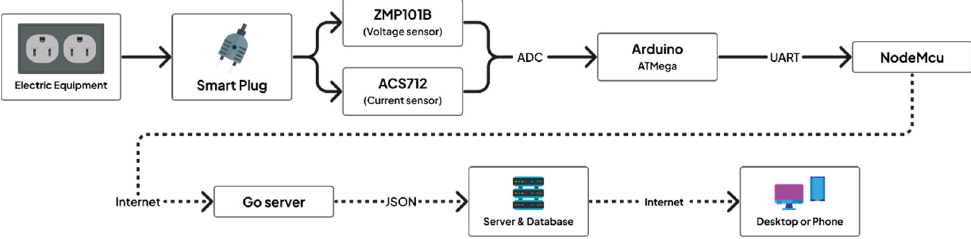
Figure 3. The power-monitoring system .